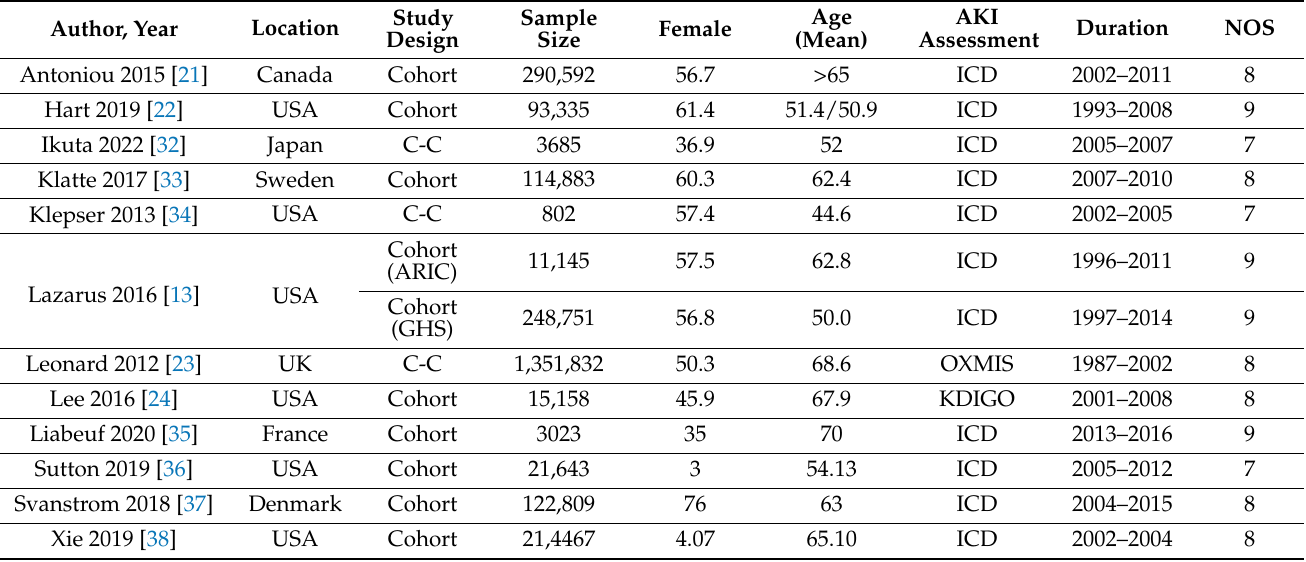
Table 1. Characteristics of studies included in the